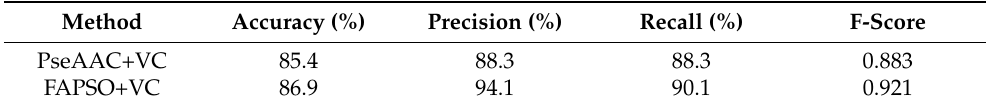
Table 6. GPCR classification performance for subfamily level.